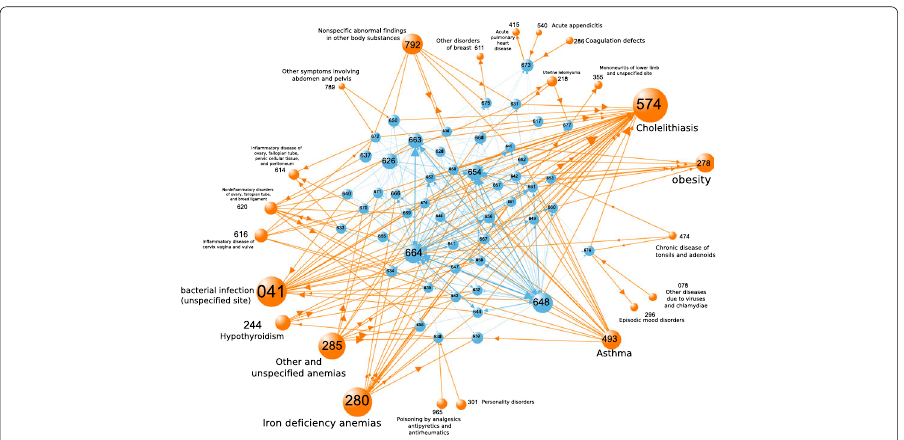
Fig. 7 Local network of pregnancy-related codes. The neighborhood of the pregnancy-related codes 630-679 as deemed significant by the φ method. The blue links are between pregnancy codes and the orange links are between pregnancy and non-pregnancy codes. Nodes sizes are proportional to